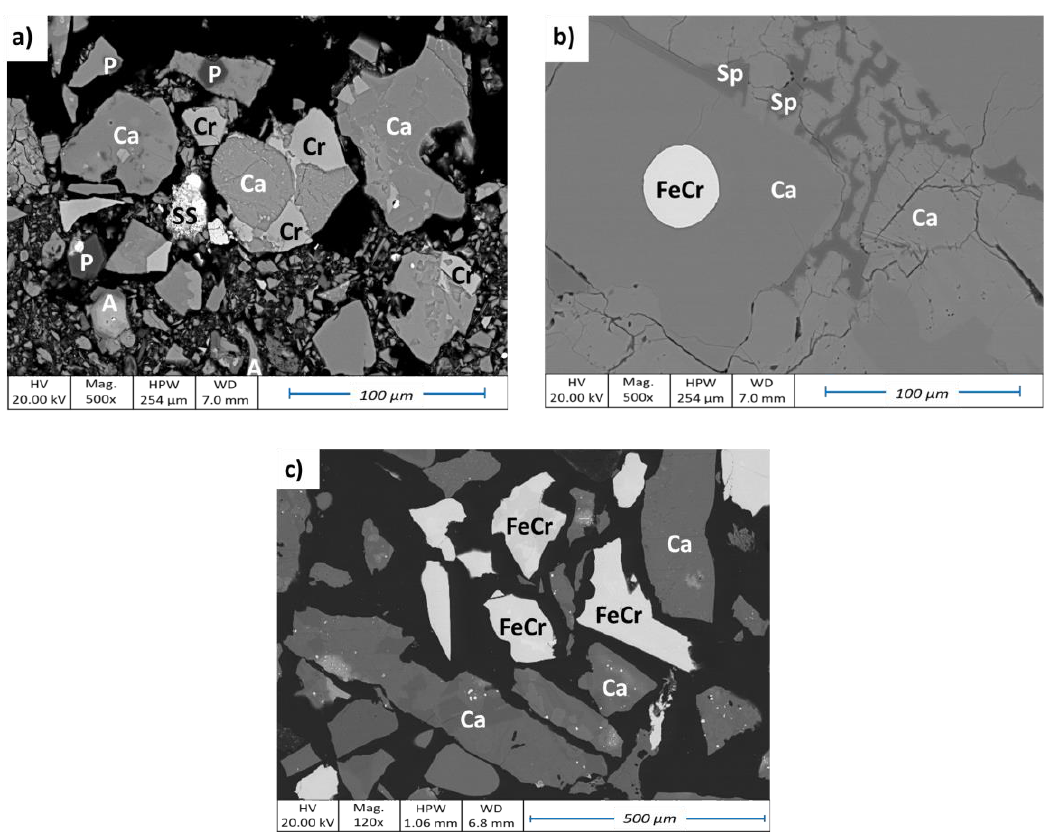
Figure 1. SEM-Backscattered Electron (BSE) images of ( a ) SS slag,( b ) LC FeCr slags and ( c ) HC FeCr slag. SS = stainless steel, Ca = Ca- silicates, A = CaMgAl-silicates, Cr = Cr-rich spinel phase, P = Periclase, Sp = spinel, FeCr = Ferrochrome particle. Phase identifications are based on SEM-EDS analysis.